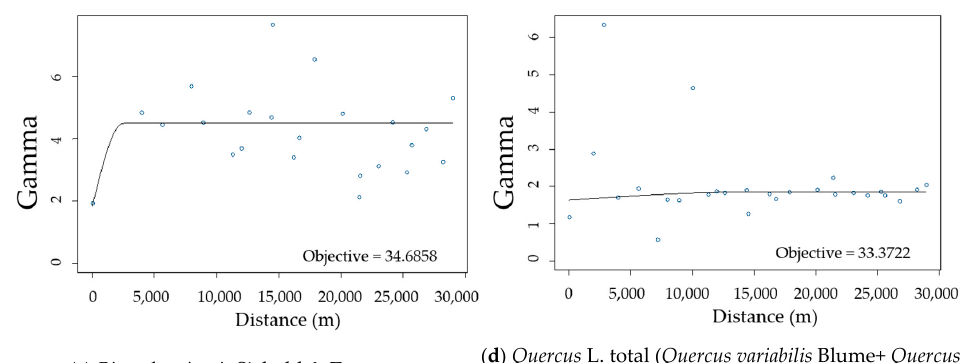
Figure 6. Semi-variogram analysis for each species (non-spatial model).